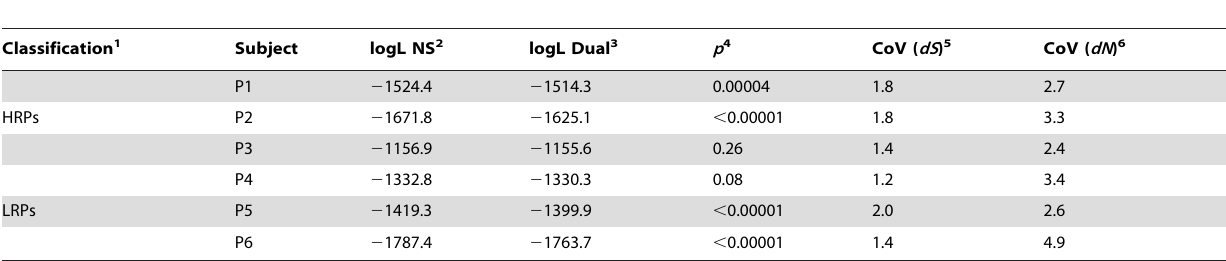
Table 1. Analysis of among-site dN and dS rate variation in six HLA-B*5701